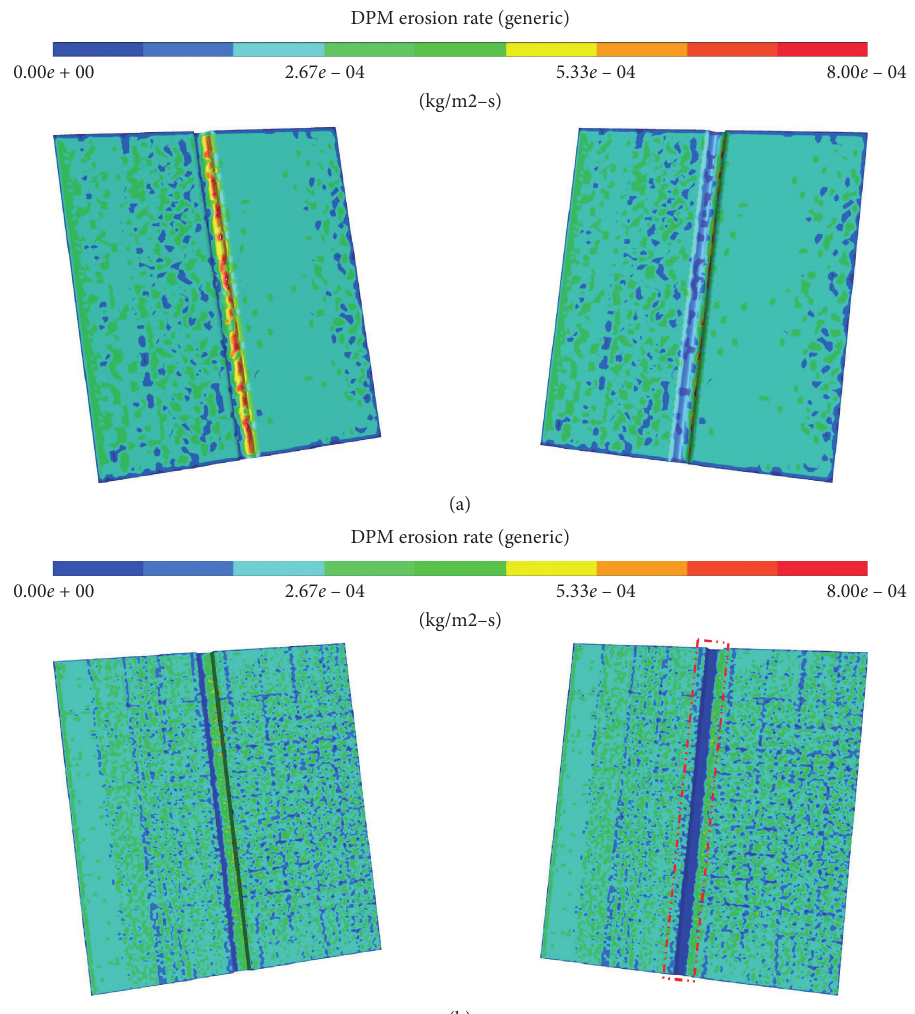
Figure 10: Wind erosion rate distribution on the two different grooved wall surfaces at the impact angle of 45 ° and wind velocity of 23m/s: (a) side views of erosion rate distribution on the grooved wall surface which contains a semicircular shape groove; (b) side views of erosion rate distribution on the grooved wall surface which contains a rectangular shape